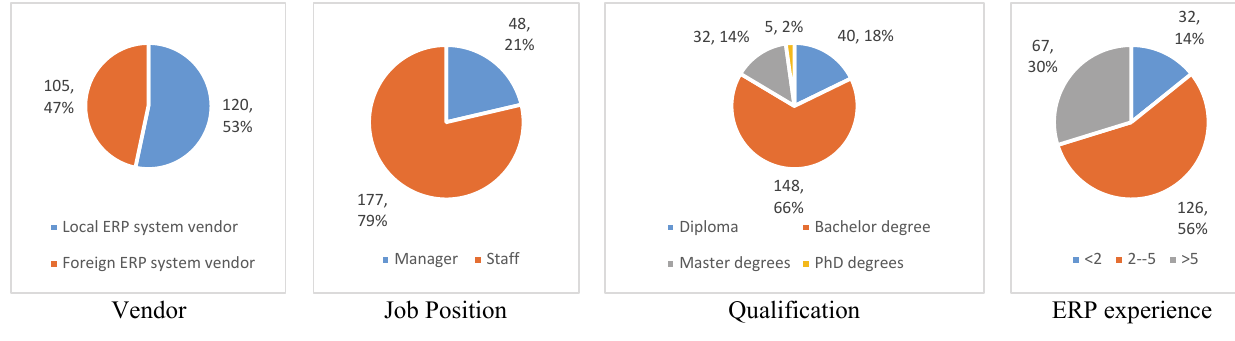
Fig. 2. Personal characteristics of the